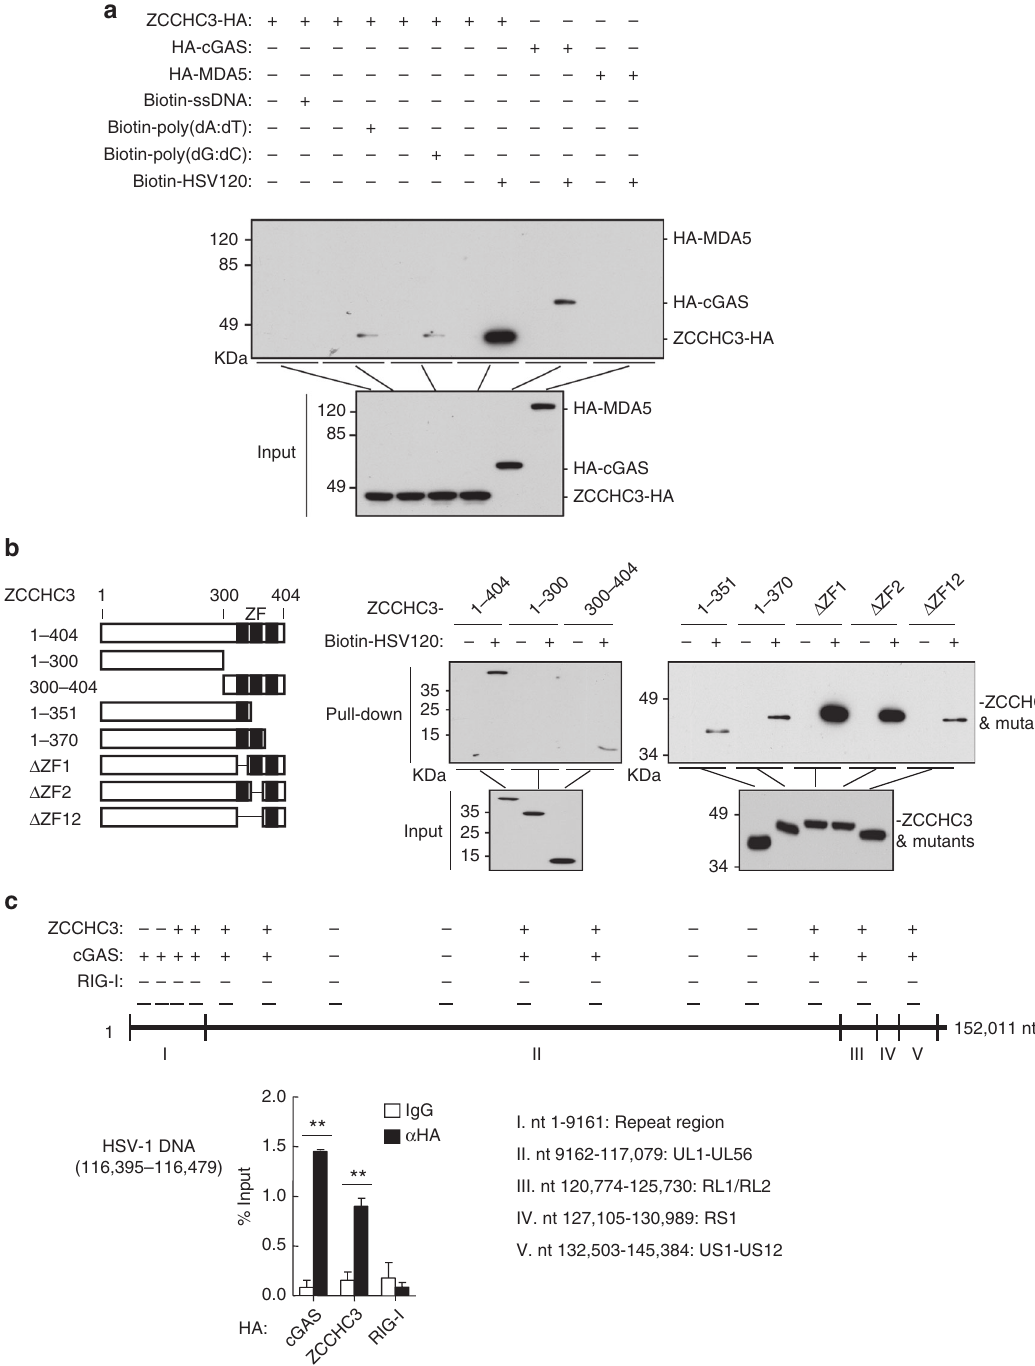
Fig. 5 ZCCHC3 binds to dsDNA. a ZCCHC3 binds to dsDNA. HEK293 cells were transfected with the indicated plasmids. Twenty hours later, the cell lysates were incubated with the indicated biotinylated nucleic acids and streptavidin-Sepharose beads for in vitro pull-down assays. The bound proteins were then analyzed by immunoblots with anti-HA. b ZCCHC3 binds to dsDNA through its C-terminal ZF domains. HEK293 cells were transfected with the indicated plasmids. Twenty hours after transfection, the cell lysates were incubated with biotinylated-HSV120 and streptavidin-Sepharose beads. The bound proteins were analyzed by immunoblots with anti-Flag. A schematic representation of ZCCHC3 and its truncation mutants was shown on the left. c ZCCHC3 and cGAS but not RIG-I bind to HSV-1 DNA of infected cells. HEK293 cells were transfected with HA-tagged ZCCHC3, cGAS, and RIG-I. Twenty hours after transfection, cells were infected with HSV-1for 3 h. Cell lysates were then immunoprecipitated with control IgG or anti-HA. The protein-bound DNAs were extracted and analyzed by qPCR analysis with primers corresponding to the indicated regions of HSV-1 genome. Positive ( + ) and negative (-) detections were shown at the top of the schematic presentation of the HSV-1 genome. A representative qPCR results were shown at the left. **P < 0.01 (unpaired t test). Data are representative of three experiments with similar